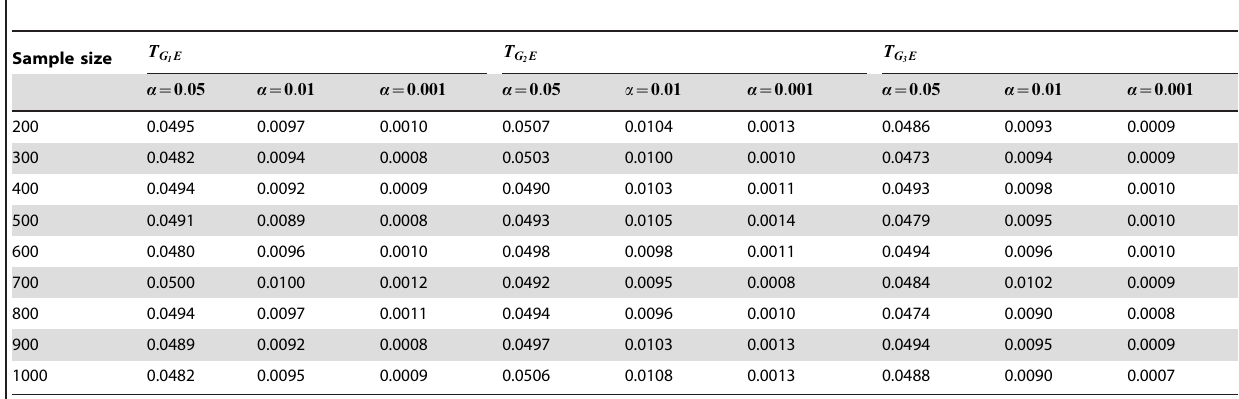
to test gene-environment interaction, assuming OR g ~ 1 and OR e ~ 1 . i E